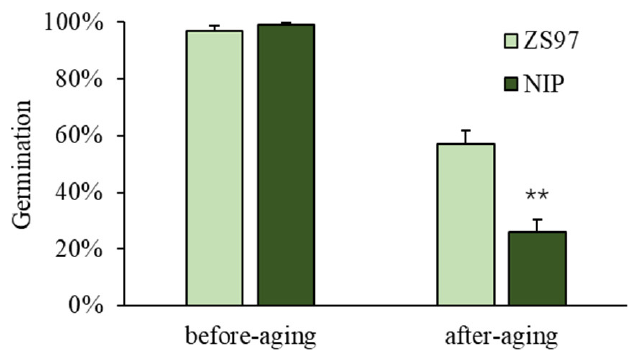
Figure 1. Seed germination phenotype of the two parents NIP and ZS97 before and after artificial aging. ** indicates a significant difference with ZS97 at p < 0.01. p -values were calculated by Student’s t -test.